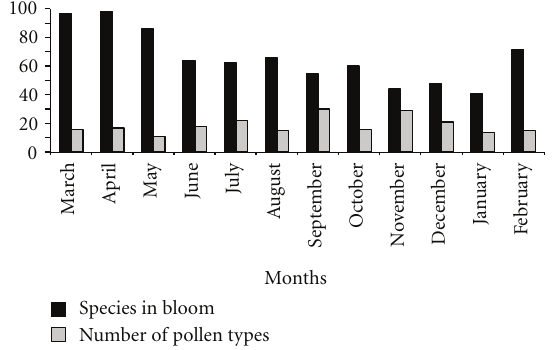
Figure 7: Number of flowering species and species used by Scaptotrigona a ff . depilis during one year (March 2010 to February 2011) in the University